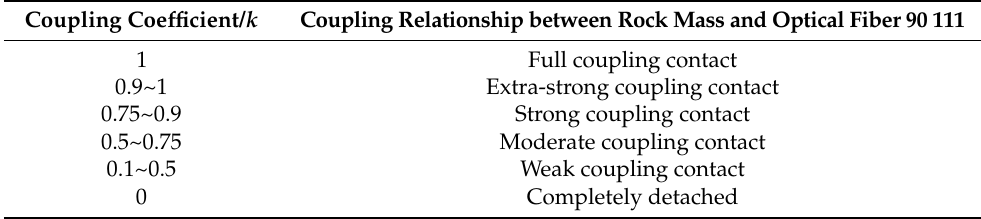
Table 2. Evaluation table of coupling relationship between rock mass and optical fiber. Coupling Coefficient/